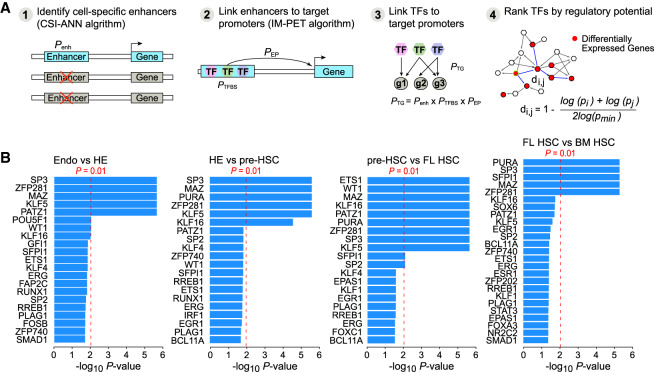
Developmental stage-specific transcriptional regulatory networks (TRNs) and key regulators in the networks. (A) Schematic for the computational framework for constructing the TRNs. The framework consists of four key steps: (1) identifying stage-specific enhancers using epigenetic signatures, (2) linking enhancers to target promoters using the IM-PET algorithm, (3) linking TFs to target promoters using a probabilistic scoring function PTG, and (4) identifying key TFs based on their regulatory potential on differentially expressed genes. (B) Key TFs predicted for four developmental transitions.